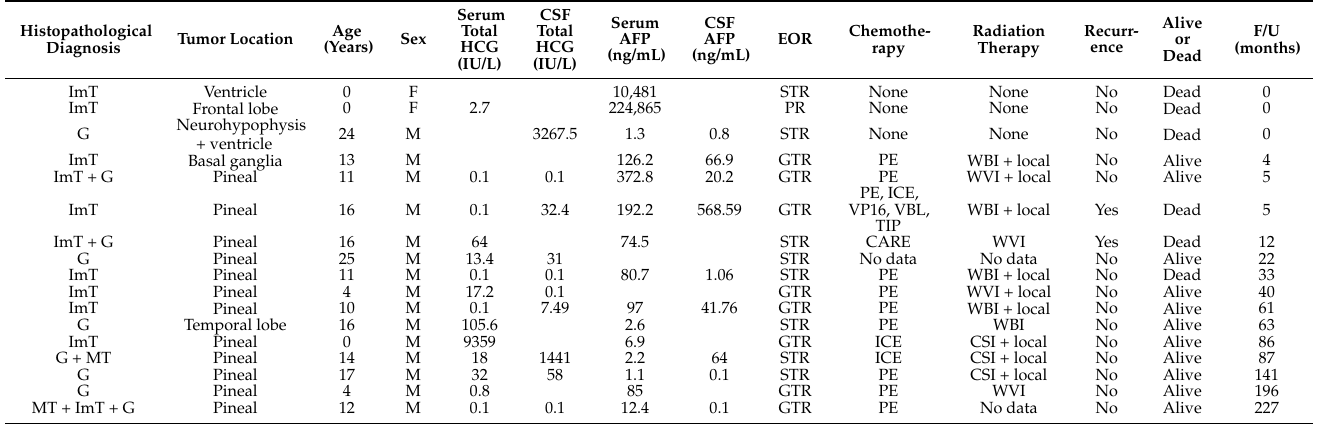
Table 1. Clinical characteristics and follow-ups of 17 cases with positive tumor markers and no ma- lignant non-germinomatous histopathological component, obtained from large resection specimens. Histopathological Diagnosis